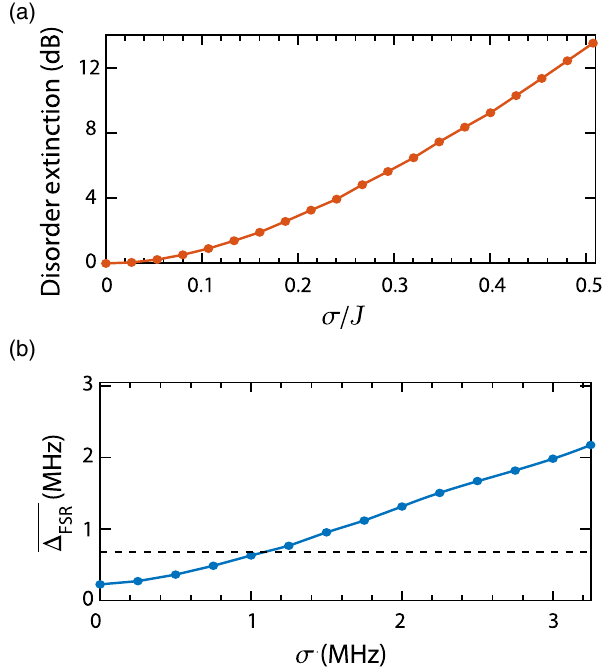
FIG. 8. (a) Numerically calculated extinction as a function of disorder. Here, σ is the disorder in the bare frequencies of the (unit-cell) resonators making up the metamaterial waveguide, and J is the coupling between nearest-neighbor resonators in the resonator array. 50 unit cells are used in this calculation, which includes taper-matching sections at the input and output of the array that bring the overall passband ripple to 0.01 dB. For a given disorder strength σ , disorder extinction is calculated by taking the mean of the transmission across the passband for a given disorder realization and subsequently averaging that mean transmission over many disorder realizations. Note that the calculated values depend on the number of unit cells. (b) Numeri- cally calculated variance in normal mode frequency spacing as a function of disorder. See the text for details on the method of calculation of Δ . The dashed line indicates the experimentally FSR measured Δ , which is extracted from the data shown FSR in Fig.